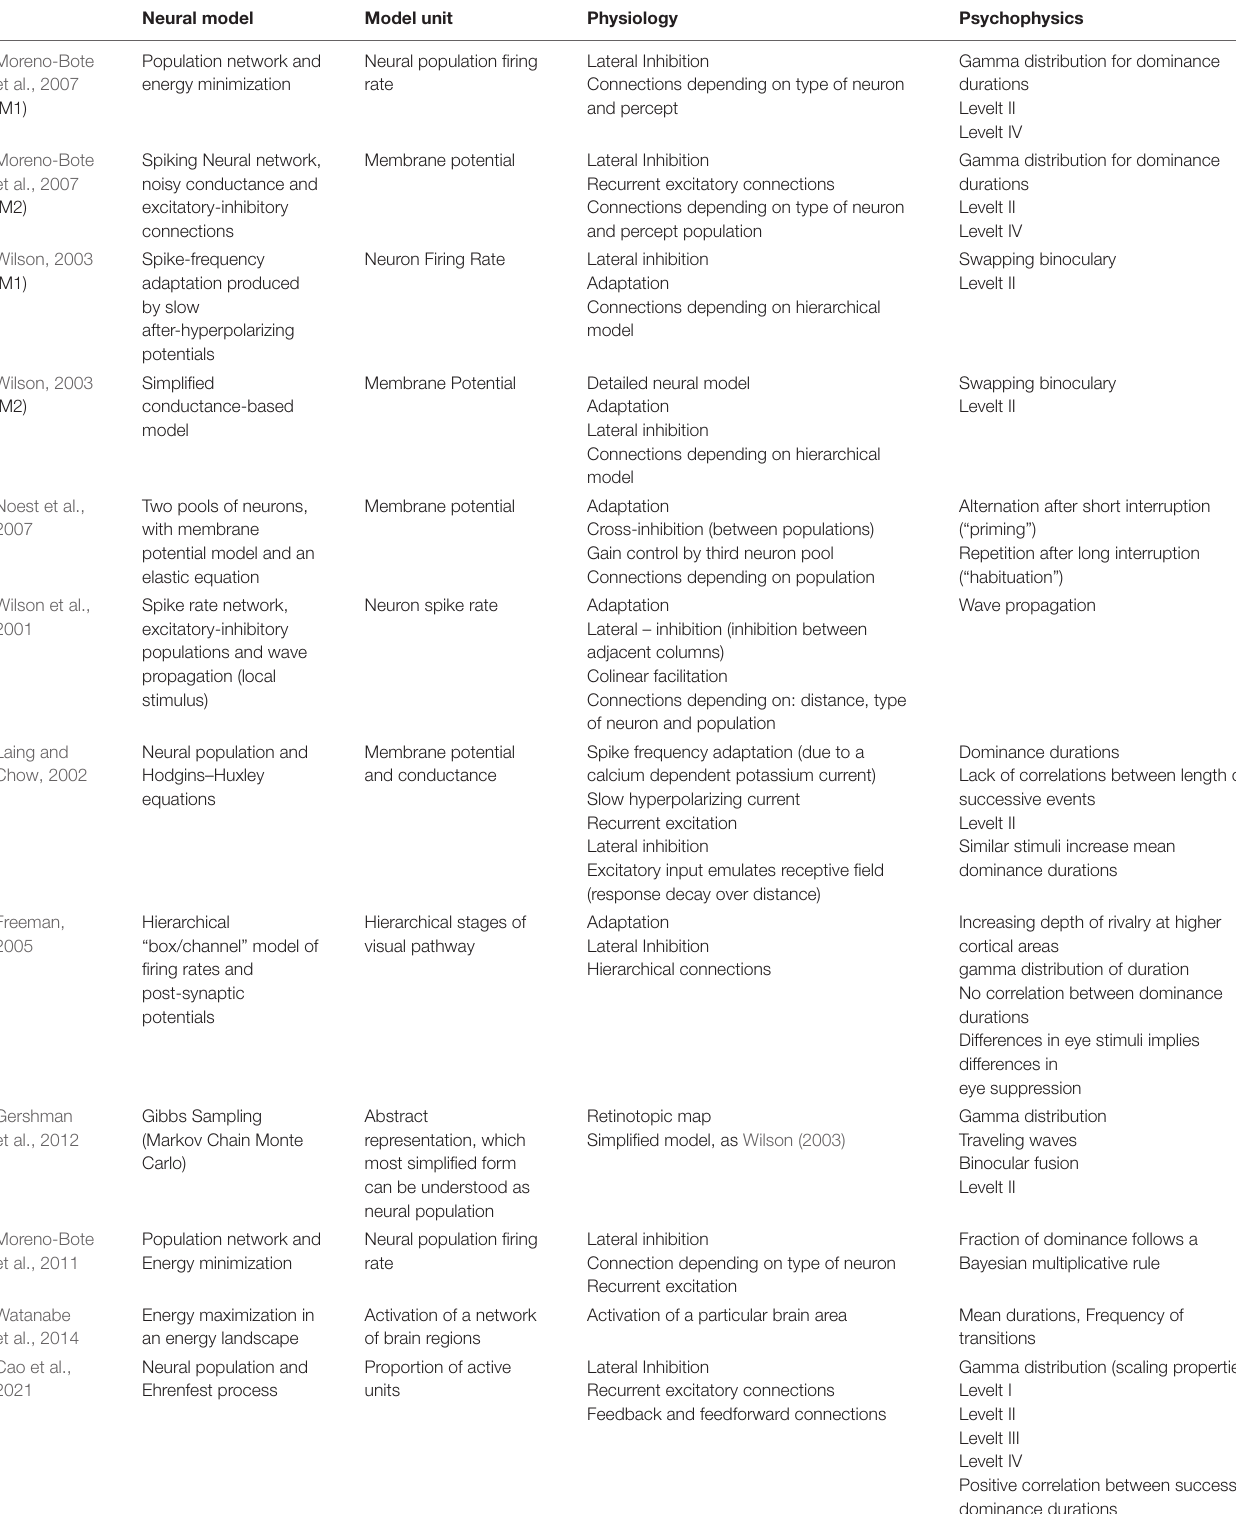
TABLE 1 | Models of visual bi-stable